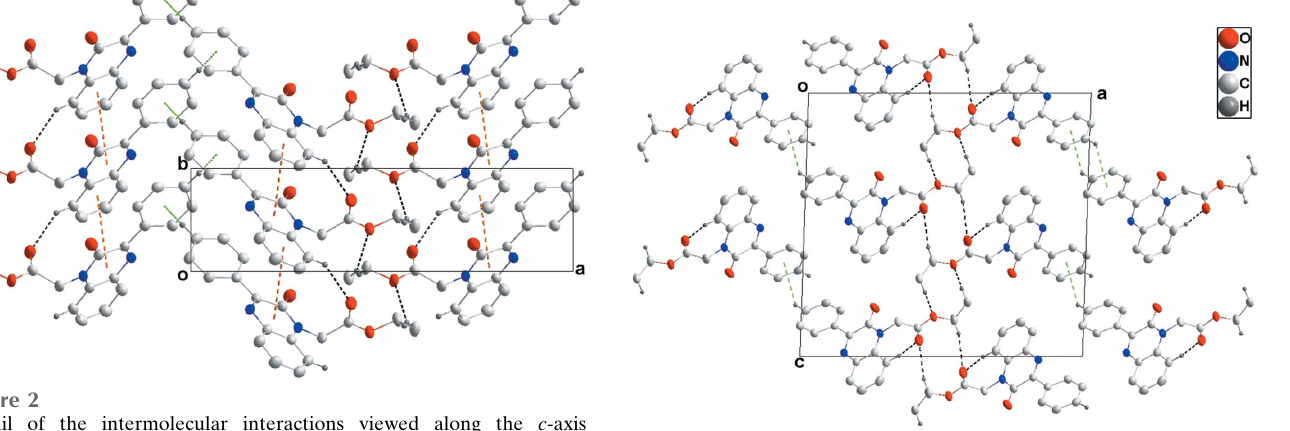
Figure 3 Packing viewed along the b -axis direction with intermolecular inter- actions depicted as in Fig. 2.